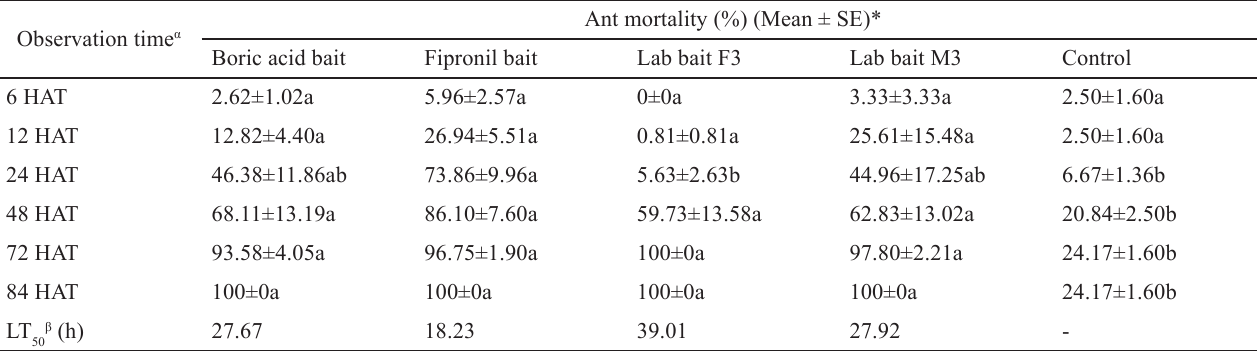
Table 4 . Mortality of M. chinensis by lab baits F3 and M3 against two commercial baits under laboratory conditions.